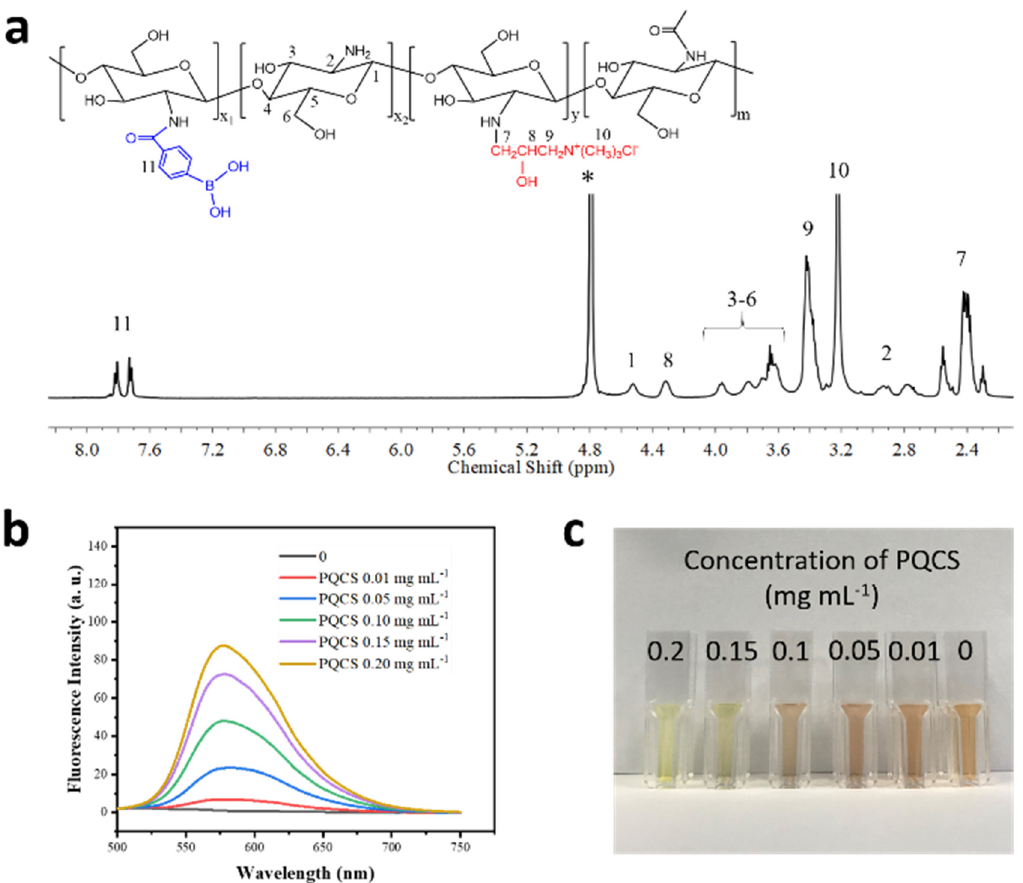
Figure 2. ( a ) 1 H NMR spectrum for PQCS in D 2 O, the inset shows the chemical structure of PQCS. The solvent peak are marked with asterisk (*). ( b ) Fluorescence spectra of AR (0.034